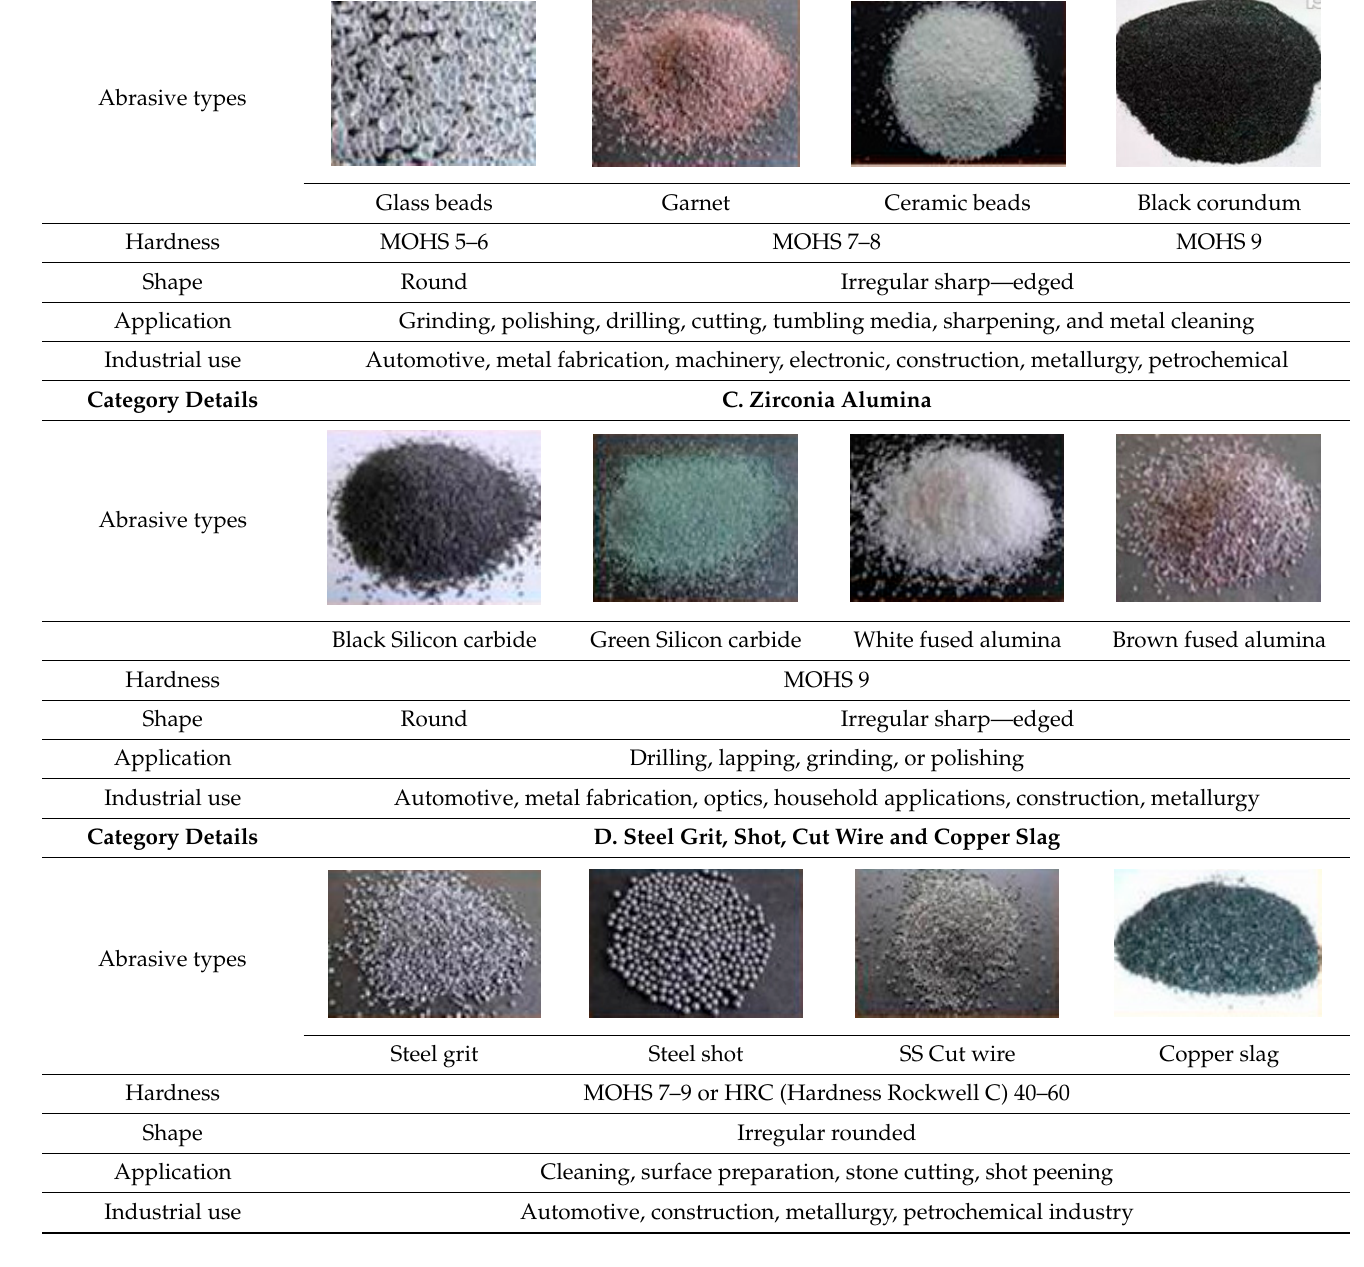
Table 5. Abrasive material categories along with their properties and industrial applications [1,68,87,88].